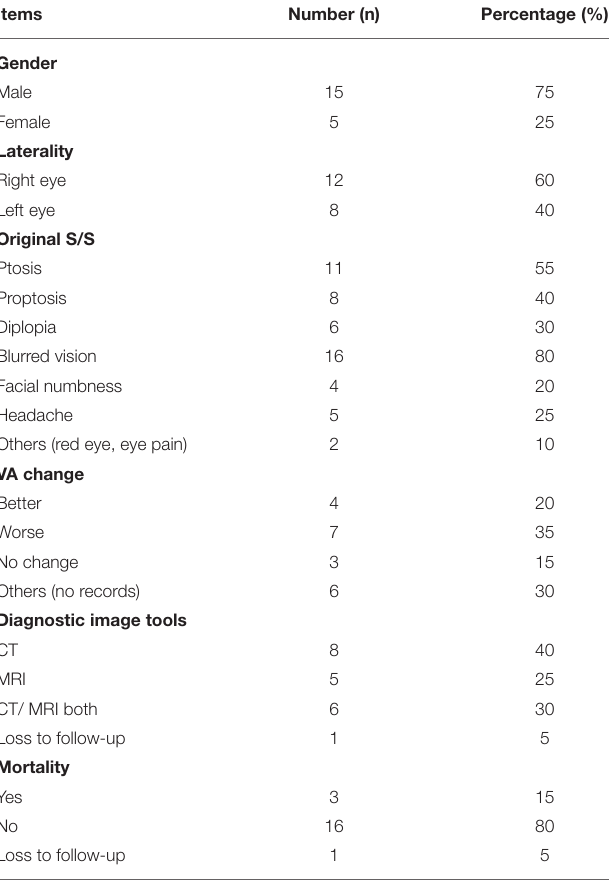
TABLE 2 | Details of clinical presentation, etiology, visual change, diagnostic tools and mortality in our case